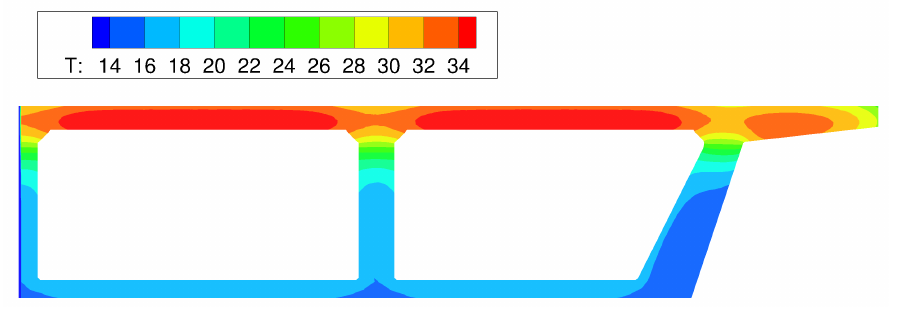
Figure 18. Simulated iso-contours of temperature (in ◦ C) at t = 10h.